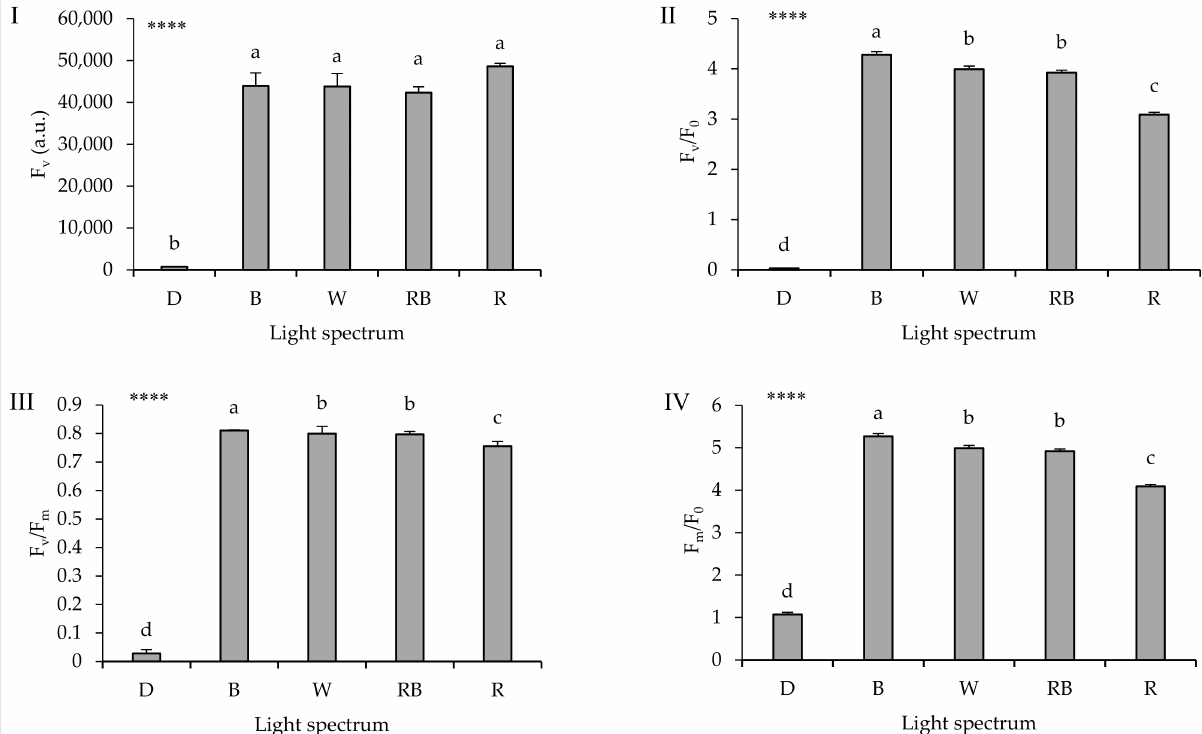
Figure 5. Chlorophyll a fluorescence of the OJIP-test including F v ( I ), F v /F 0 ( II ), F v /F m ( III ) and F m /F 0 ( IV ); equations and explanations in Table 2) from leaves sampled from grafted watermelon seedlings exposed for 12 days to either darkness (D) or different light quality regimes [blue (B), white (W), red and blue (RB), as well as red (R); see spectrum in Supplementary Figure S3]. Photosynthetic photon flux density was 20 ± 1 µ mol m − 2 s − 1 during the first 2 days, and 50 ± 1 µ mol m − 2 s − 1 during the following days. Nine plants per treatment were assessed. Different letters indicate that values are significantly different at p < 0.01 according to Duncan’s multiple range tests. Bars represent SEM. Significance at the 0.0001 probability level is indicated by